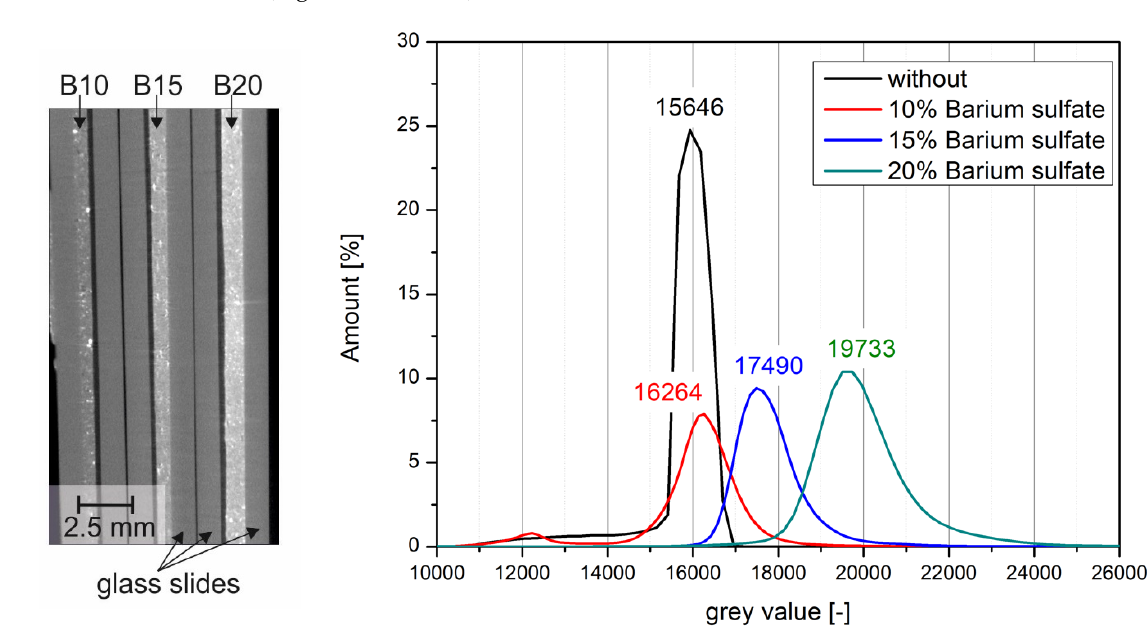
Figure 11. Cross-section through the CT scan of the bitumen samples with 10 wt%, 15 wt%, and 20 wt% barite powder ( left ) and evaluation of the gray scale histograms for the different dosages ( right ).